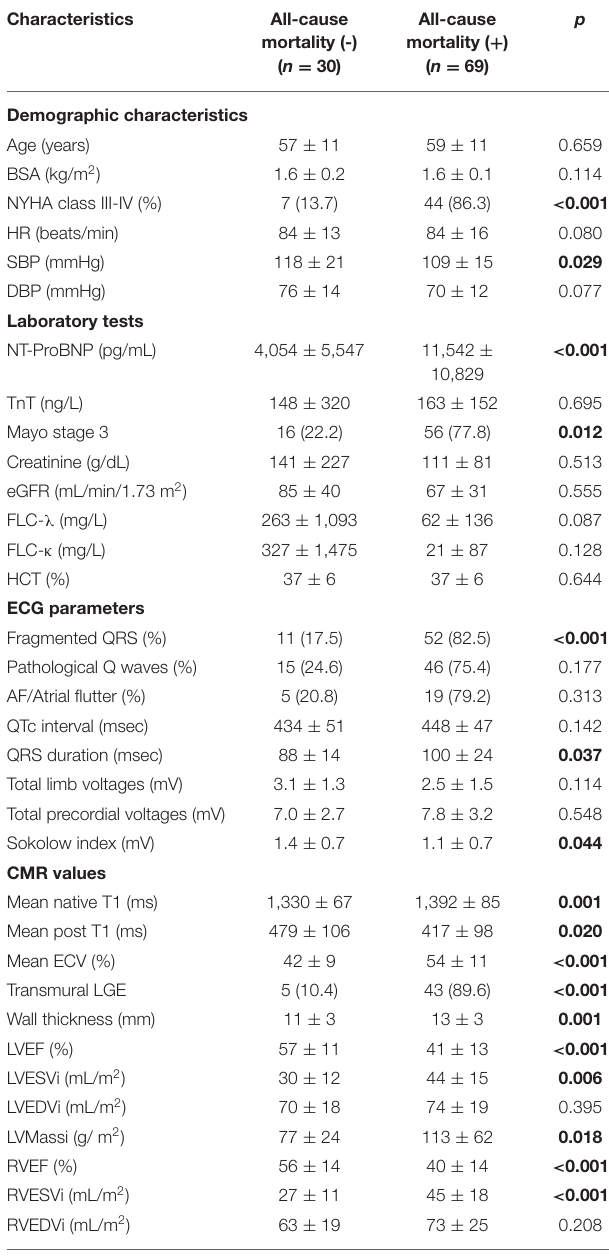
TABLE 1 | Comparison of baseline clinical characteristics of patients with or without all-cause mortality. Characteristics